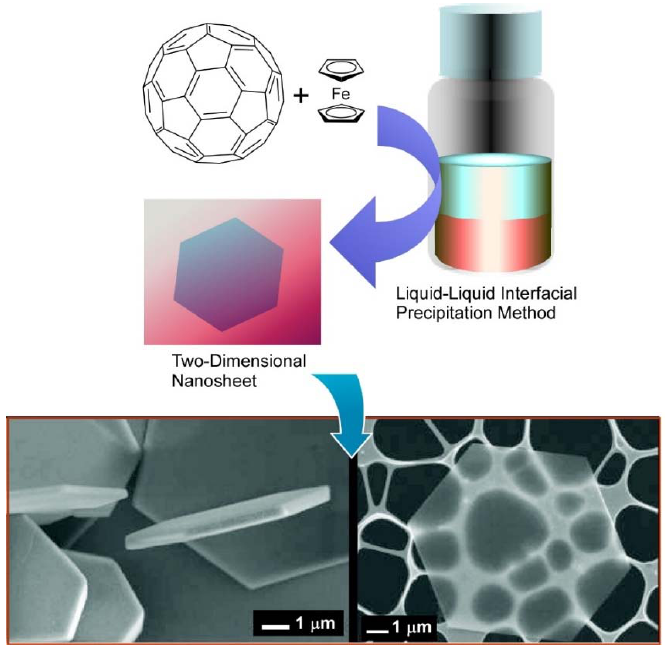
Figure 7. Two ‐ dimensional C 60 /ferrocene nanosheets prepared by liquid–liquid interfacial precipi ‐ tation method. Reprinted with permission from [116]. Copyright 2009 American Chemical Society.